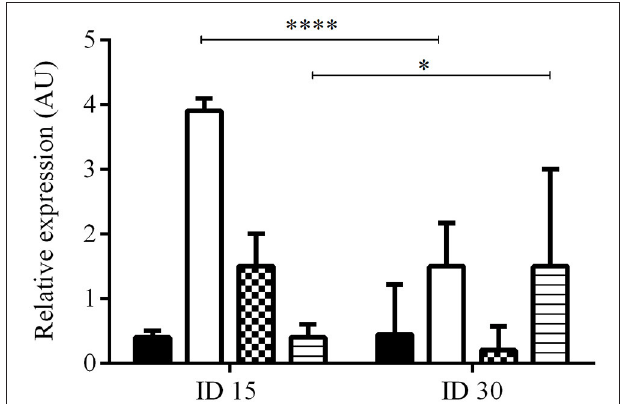
FIGURE 3 | Treatment progress of cutaneous leishmaniasis in hamsters experimentally infected with L. (V) braziliensis . A representative photograph of lesion, (A) before treatment, (B) end of treatment, and (C) 90 days post-treatment. Note the complete re-epithelialization of the skin in